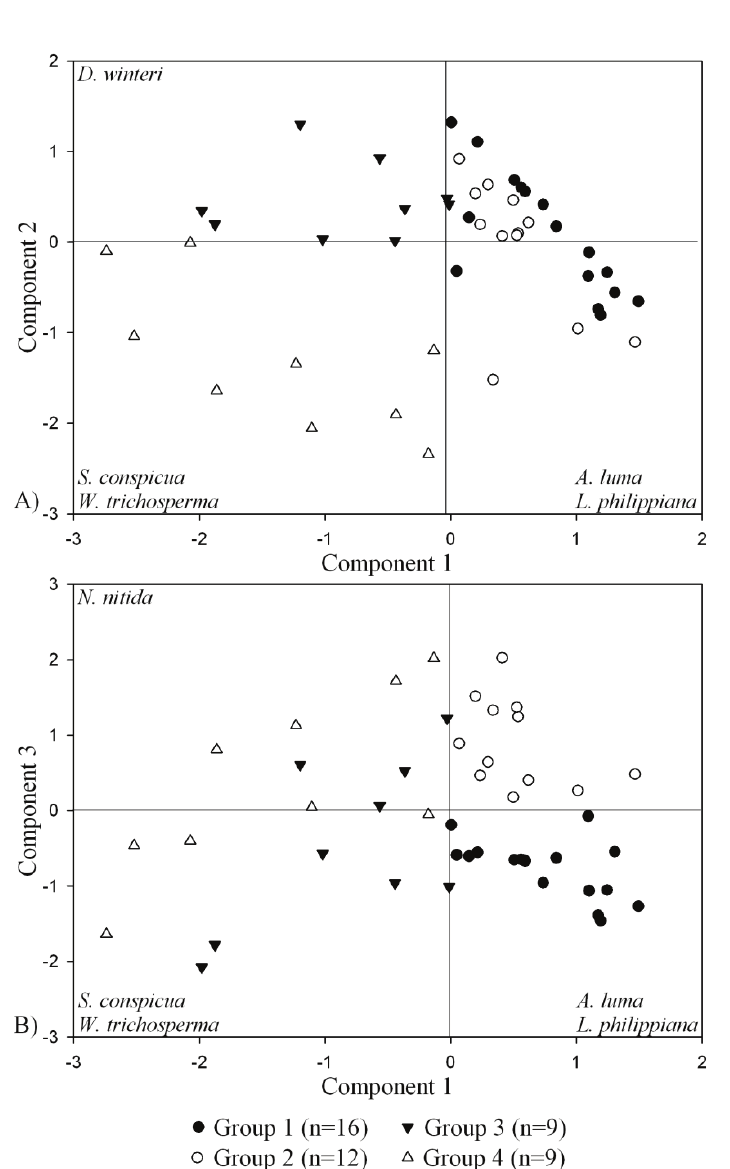
Figure 3. Diagram for (A) component 1 vs . 2 and (B) component 1 vs. 3, originated from the principal component analysis using data of importance values for tree species in the 46 sampled plots. Each symbol type represents plots of different forest